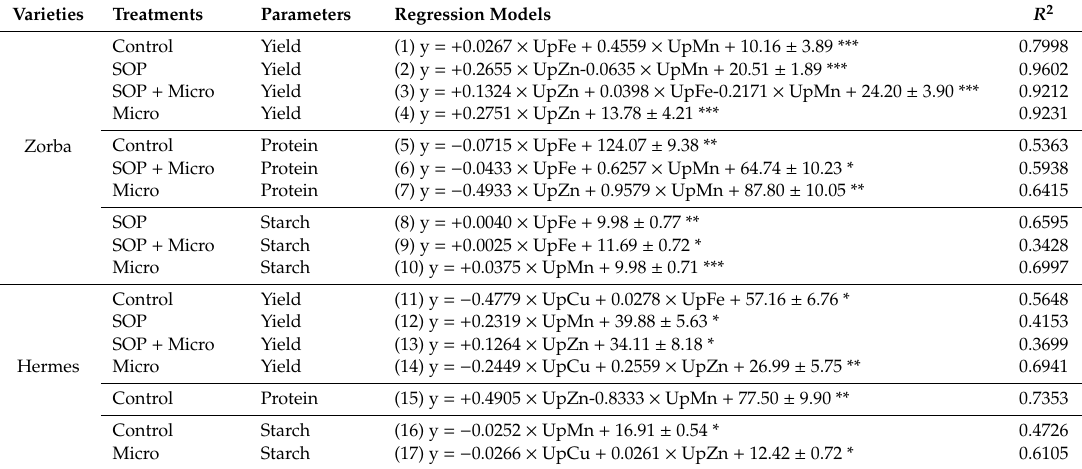
Table 4. Regression models of potato yield and the content of protein and starch as the function of micronutrient uptake at the stage of potato full